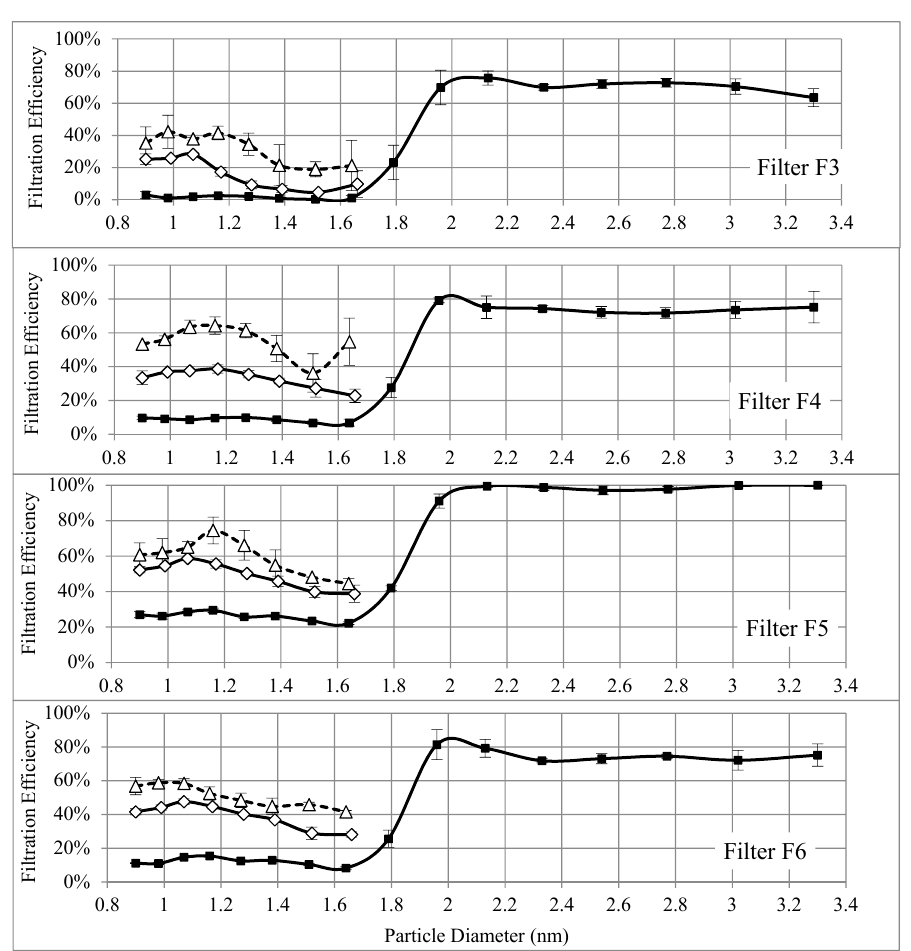
Figure 6. Particle filtration efficiencies of nanofibrous filters at three levels of particle concentrations (no dilution, 1:10 dilution, and 1:100 dilution).